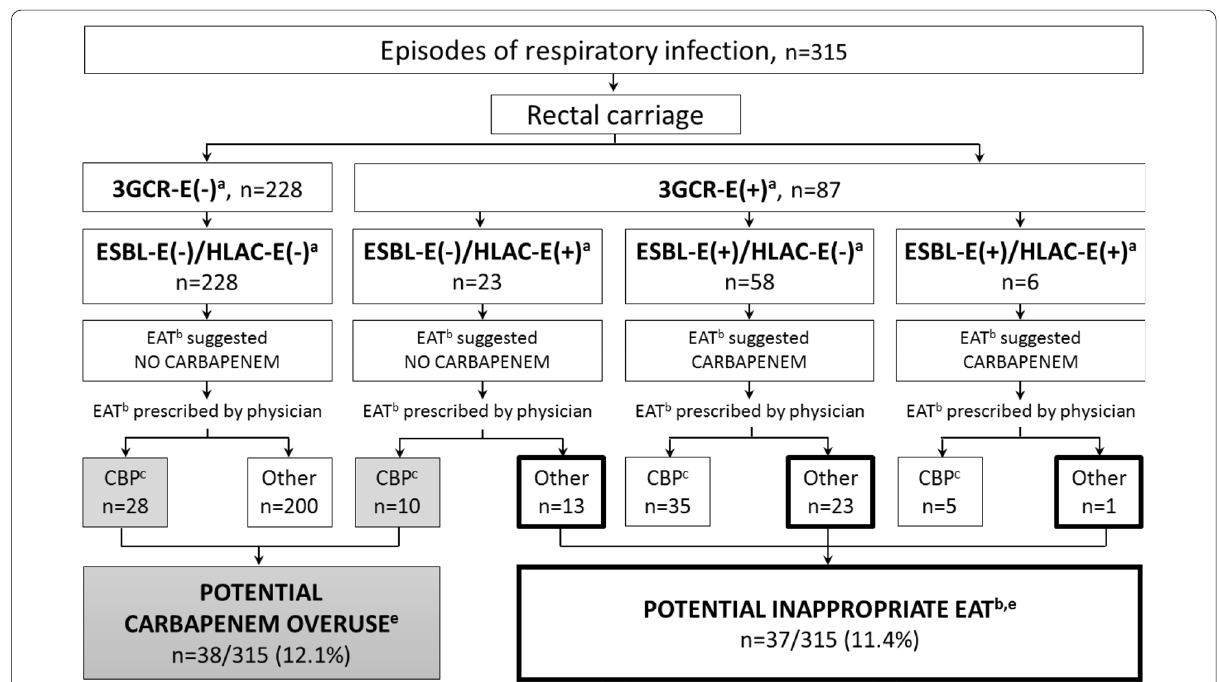
Fig. 2 Potential impact of rectal colonization surveillance on empirical antimicrobial therapy (EAT) and on use of carbapenems. a 3GCR-E: third-generation cephalosporins resistant Enterobacterales ; ESBL-E: Extended-spectrum beta-lactamase producing Enterobacterales ; HLAC-E: high-level expressed AmpC cephalosporinase-producing Enterobacterales . b EAT: empirical antimicrobial therapy. c CBP: carbapenem. d FEP: céfépime. e Potential carbapenem overuse and inappropriate EAT were determined by comparing EAT administered to EAT suggested by rectal